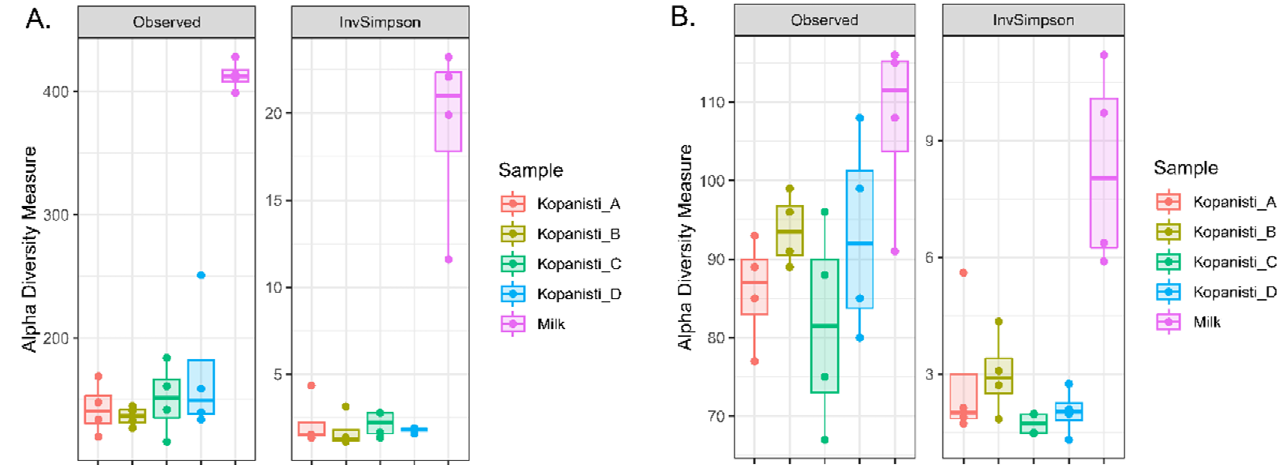
Figure 1. Alpha-diversity boxplots for ( A ) bacteria and ( B ) yeasts/fungi communities identified in pasteurized milk and Kopanisti A, B, C and D cheese samples. Statistically significant differences ( p < 0.05) were detected between each Kopanisti type and pasteurized milk for inverse Simpson indices (both bacteria and yeasts/fungi) and for Observed index (only for bacteria). Regarding the Observed index, statistically significant difference ( p < 0.05) was only detected between Kopanisti C and pasteurized milk.